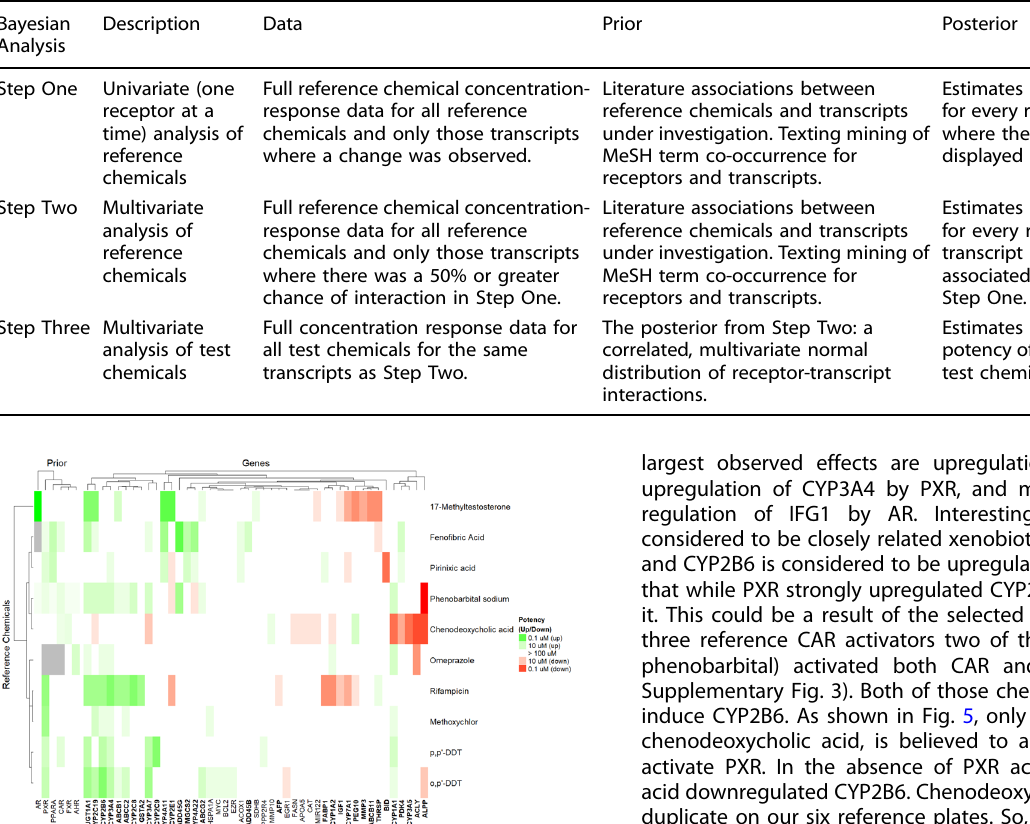
Fig. 5 Transcriptional behavior of reference chemicals. At the left- hand side the literature-curated receptor potencies are indicated, while at the right-hand side the heatmap shows the potency (darker indicates more potent) and direction (color) of the 45 transcripts found to be systematically altered by increasing concentration of the reference chemicals. The 32 transcripts found to have at least a 50% chance of non-zero interactions in the multivariate analysis are indicated in bold. Chemicals and transcripts are clustered hierarchi- cally such that those showing more similar behavior are closer together. The heatmap was created with R package Complex- Heatmap 103 using hierarchical clustering with complete linkage and Euclidean